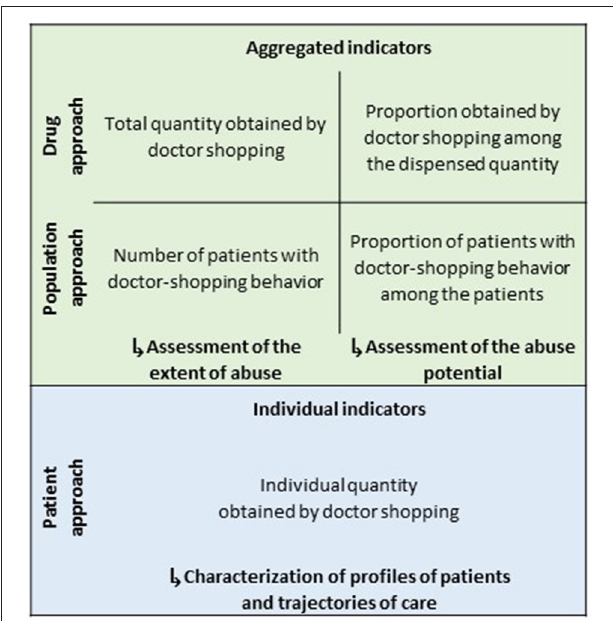
FIGURE 2 | Complementary indicators provided by the